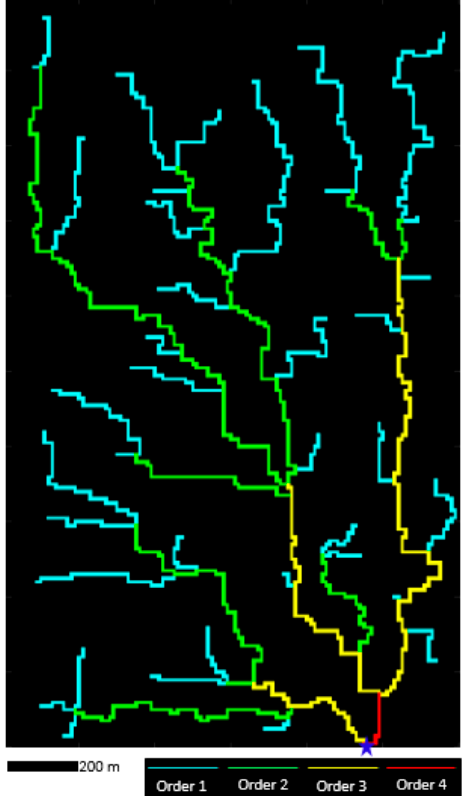
Figure 3. The branchwork pattern assuming different orders for conduits generated based on the invasion theory [38]. The blue star displays the location of the spring that initiates conduit